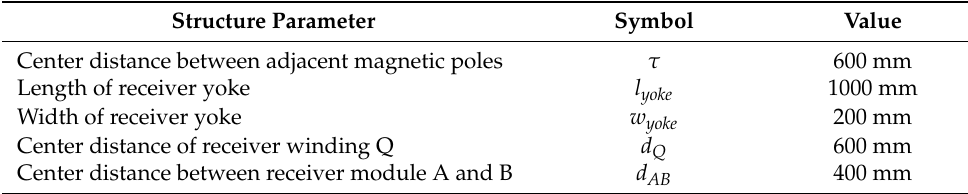
Table 1. The design case of the dual-phase NSP receiver.